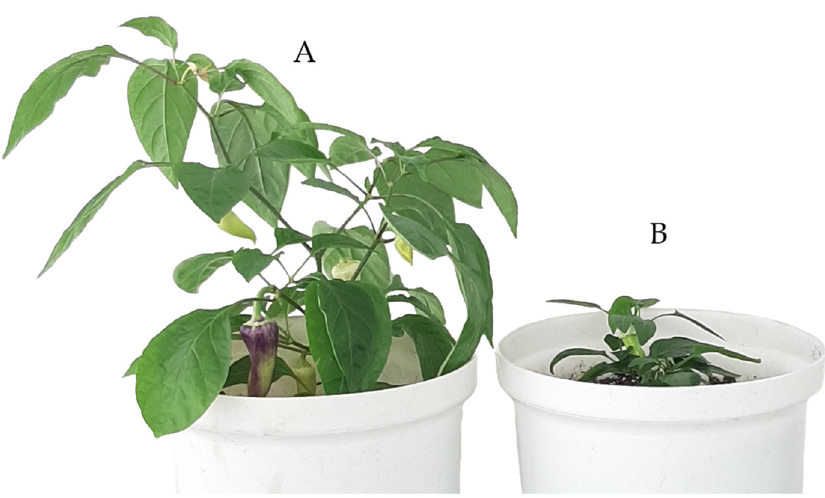
Figure 6. Morphological differences between doubled-haploid ( A ) and haploid ( B ) plants.